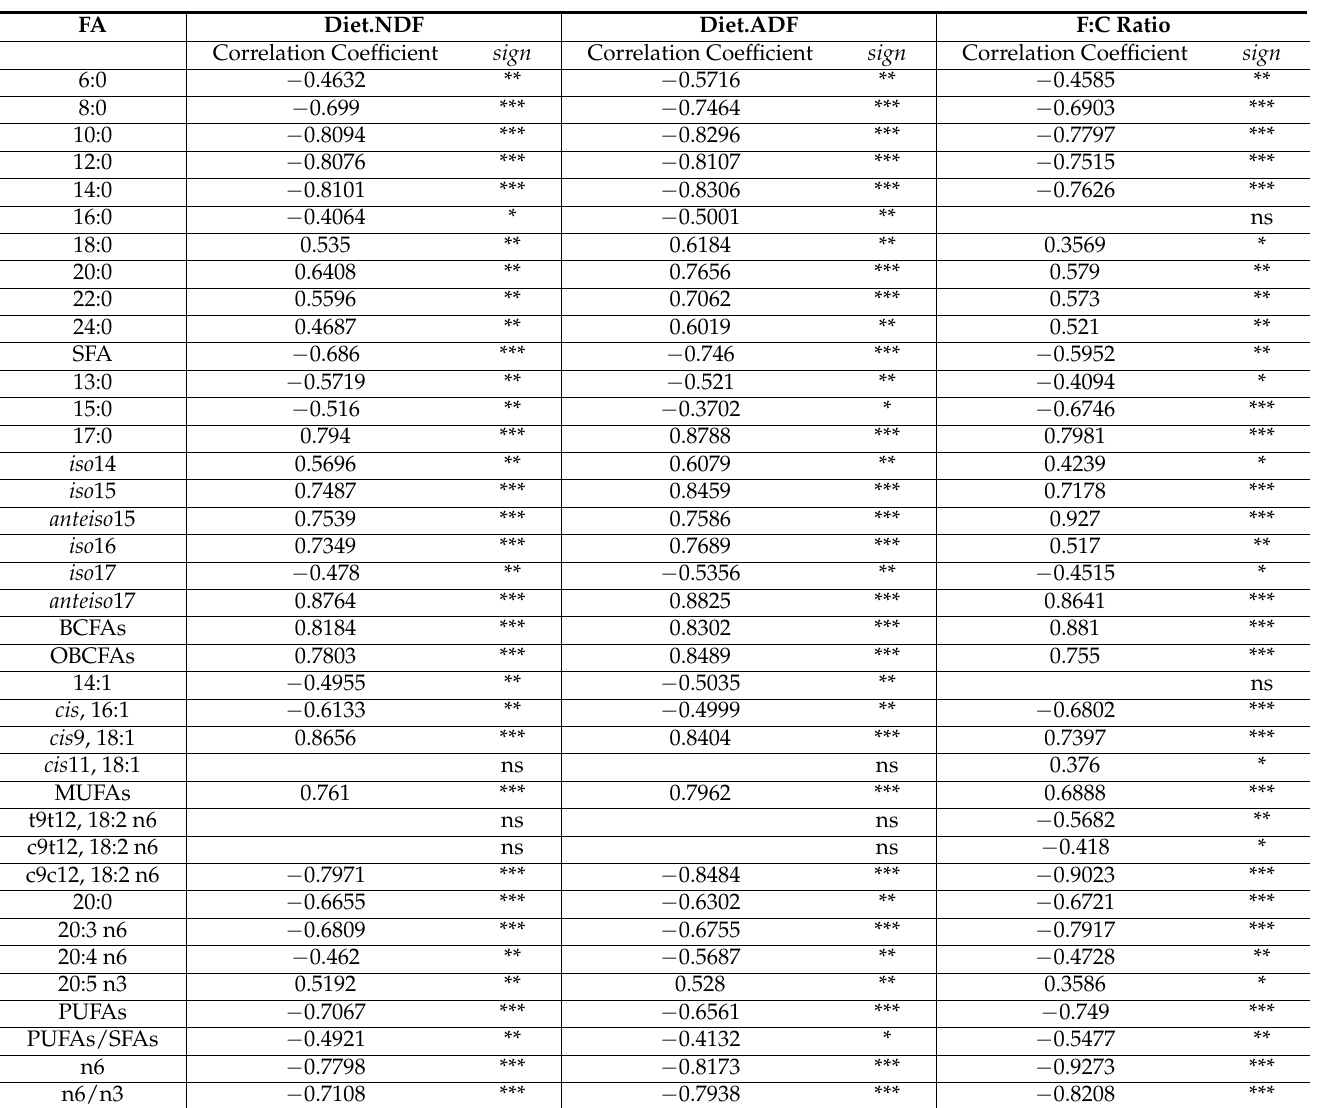
Table 4. Pairwise correlation matrix between fiber-related parameters (NDF, ADF and F:C ratio) of the diet and the percentages of FAs detected in milk. Only significant (* p < 0.05, ** p < 0.01, *** p < 0.001) correlations are